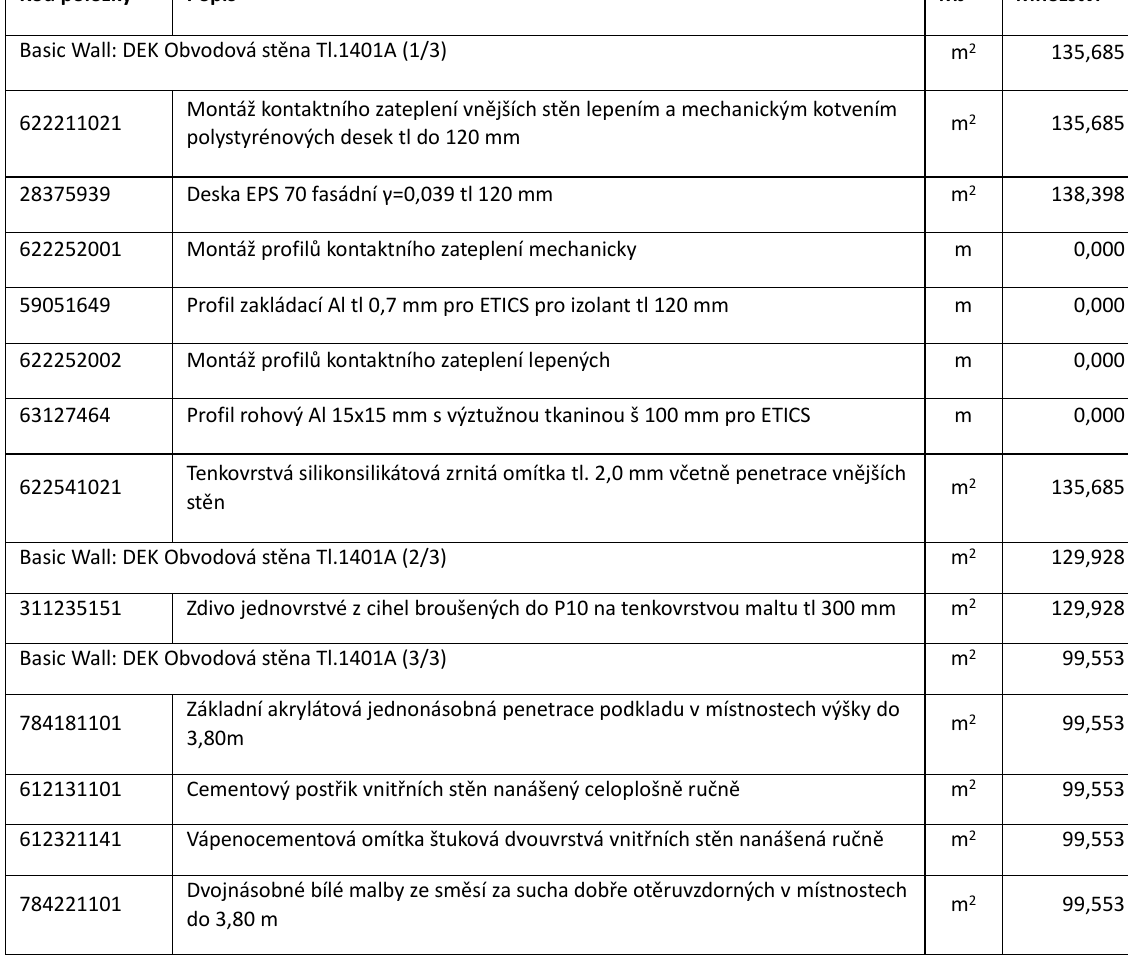
Tabulka 4: Element 4, Obvodová nosná stěna zpracována v programu KROS 4, Cenová soustava URS CZ (zdroj: ČERNOVICKÝ, Vojtěch. Bakalářská práce. V Praze: ČVUT, 2020, str.